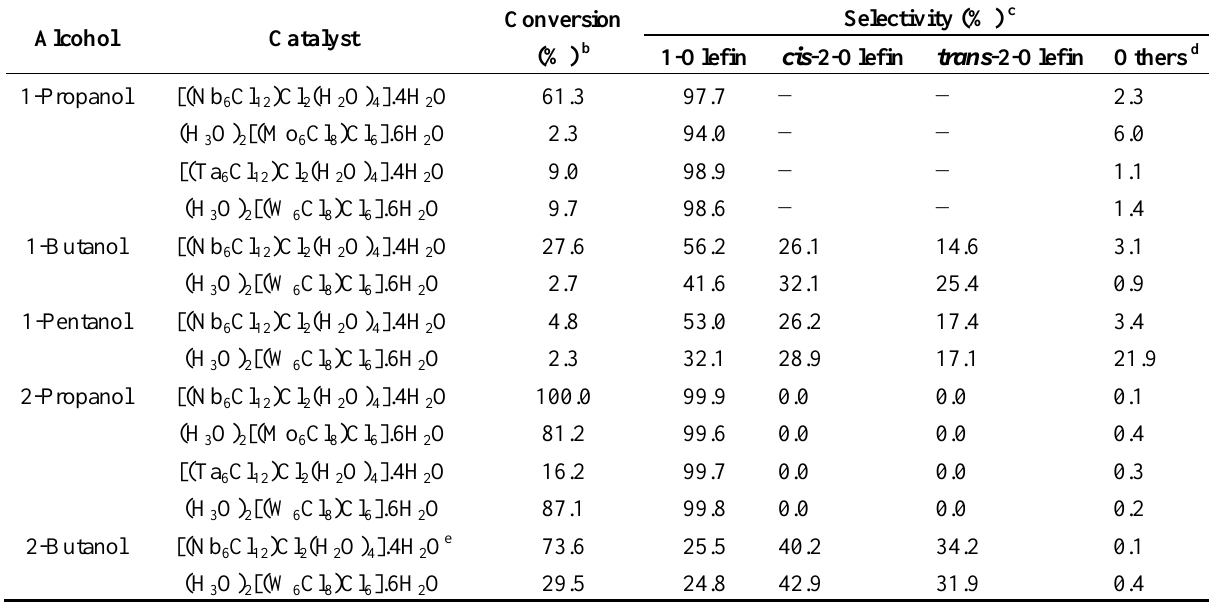
Table 5. Dehydration of alcohols over halide clusters a